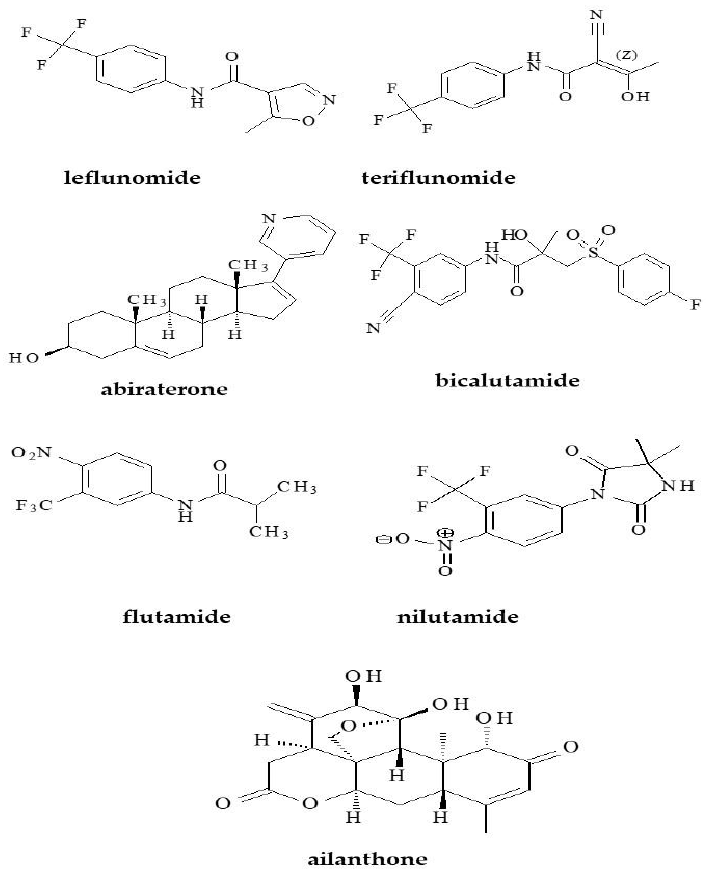
Figure 2. Chemical structures of studied anti-androgen substances .